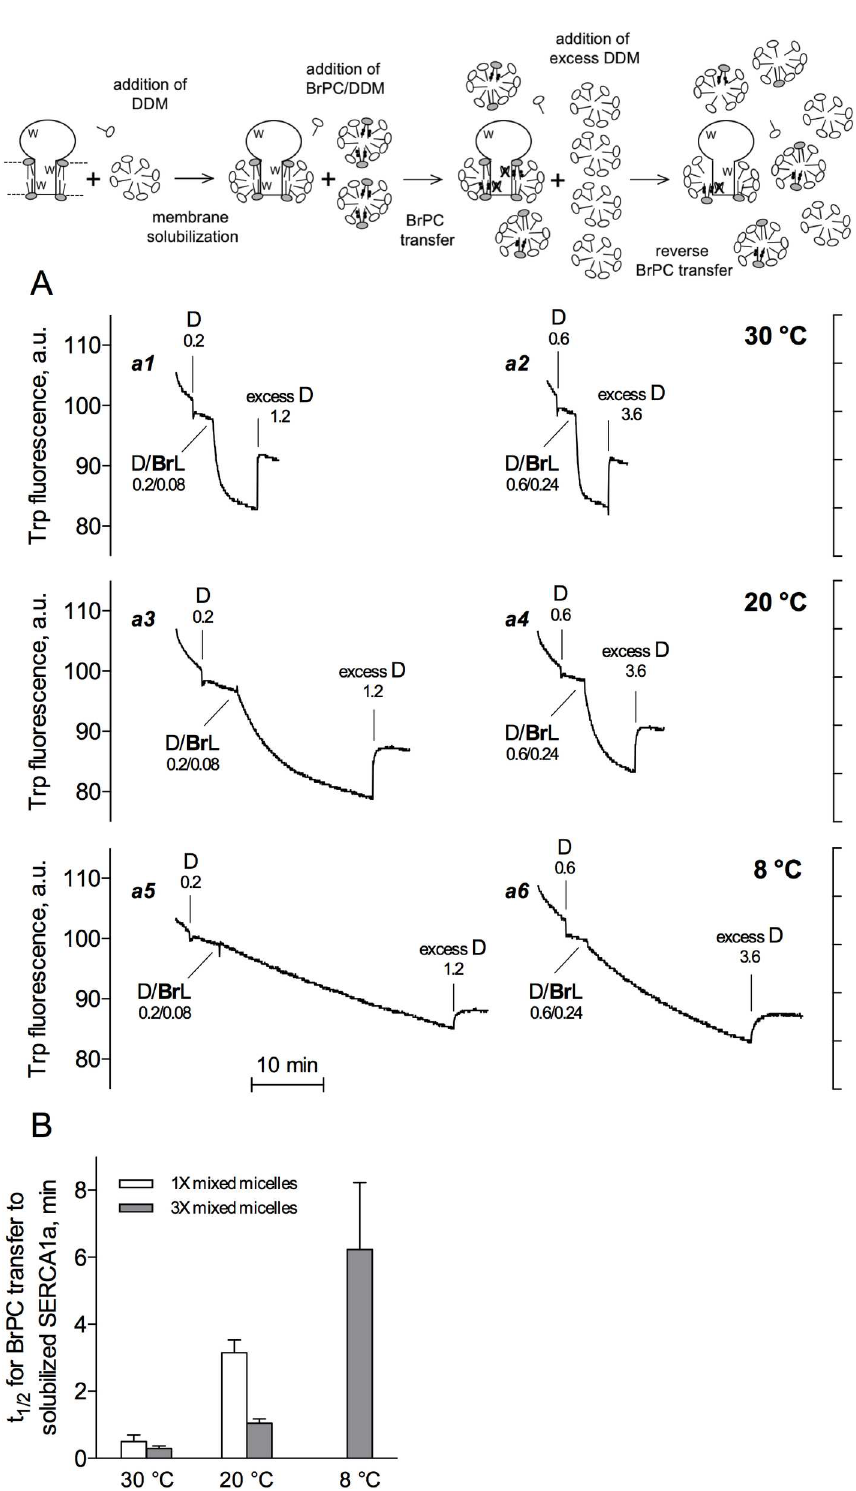
Fig 2. Kinetics of BrPCexchange in the presence of different amounts of the samemixed micelles, and at various temperatures. For these experiments, buffer B was used. (A) For Traces a1 and a2 ,the temperature was 30˚C. To SR vesiclesat 0.04 mg protein/mLand 0.02 mg endogenous lipid/mL,DDM was initiallyaddedat a concentration of either 0.2 mg/mL (Trace a1 ) or 0.6 mg/mL (Trace a2 ), resultingin